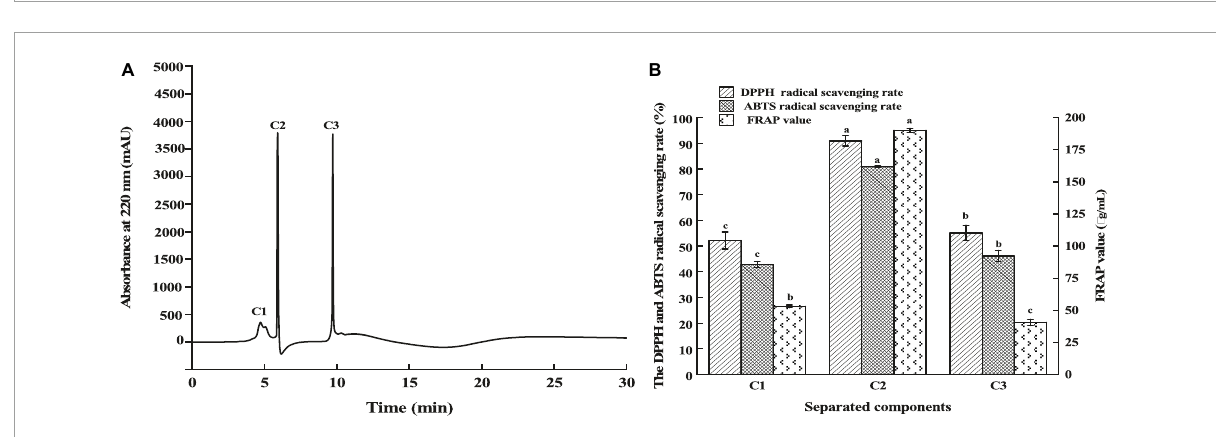
FIGURE3 Separation of the fraction C by RP-HPLC (A) and the antioxidant activity of fractions (B) . Different lowercases above the error bar suggest obvious differences in antioxidant activity of separated components ( p <